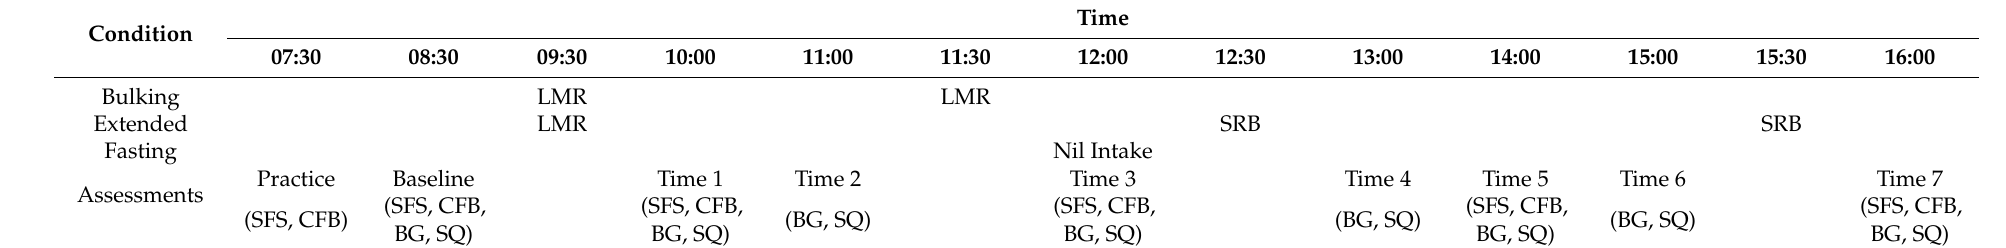
Table 2. Overview of assessment and nutritional intake timing.